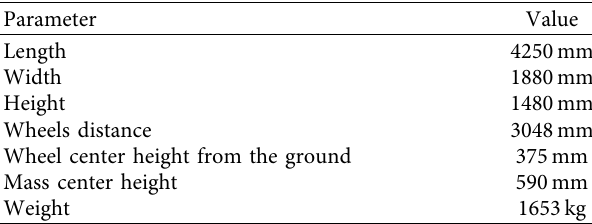
Table 2: Specifcations of E-class